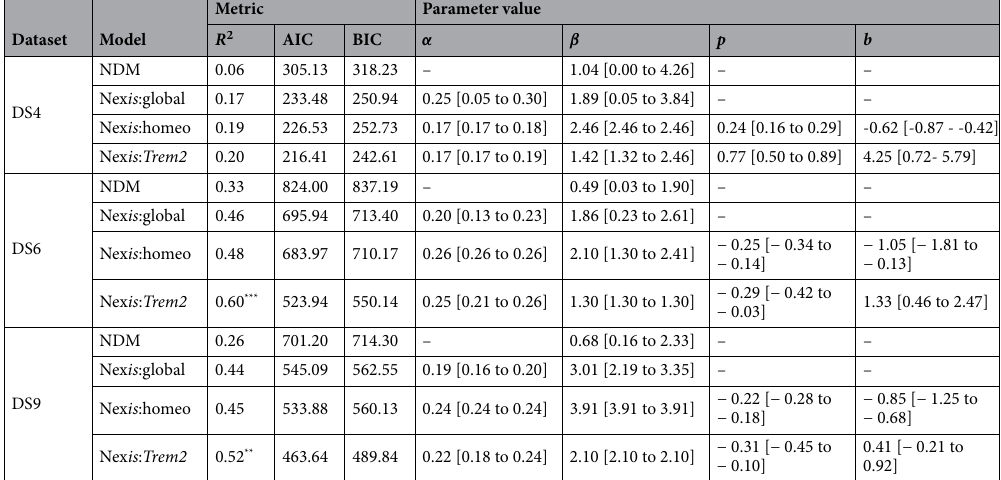
Table 1. Comparison of model fits for NDM, Nex is :global, and Nex is :microglia (homeostasis and Trem2 ) for datasets DS4, DS6, and DS9. All Nex is model fits were significantly better than those of the NDM ( p < 0.005). Nex is :microglia model fits are compared to the Nex is :global model fit (significance indicated by *). Significance of model fit comparisons is confirmed using the Fisher’s R-to-Z test. NDM: Network Diffusion Model, Nex is : Nexopathy in silico , AIC: Akaike’s Information Criteria, BIC: Bayesian Information Criteria, R 2 : model fit parameter, α : intra-regional tau accumulation rate; β : inter-regional tau spread rate; p : microglia-mediated intra-regional tau accumulation rate; b : microglia-mediated inter-regional tau spread rate. *** p = 0.001, ** p <